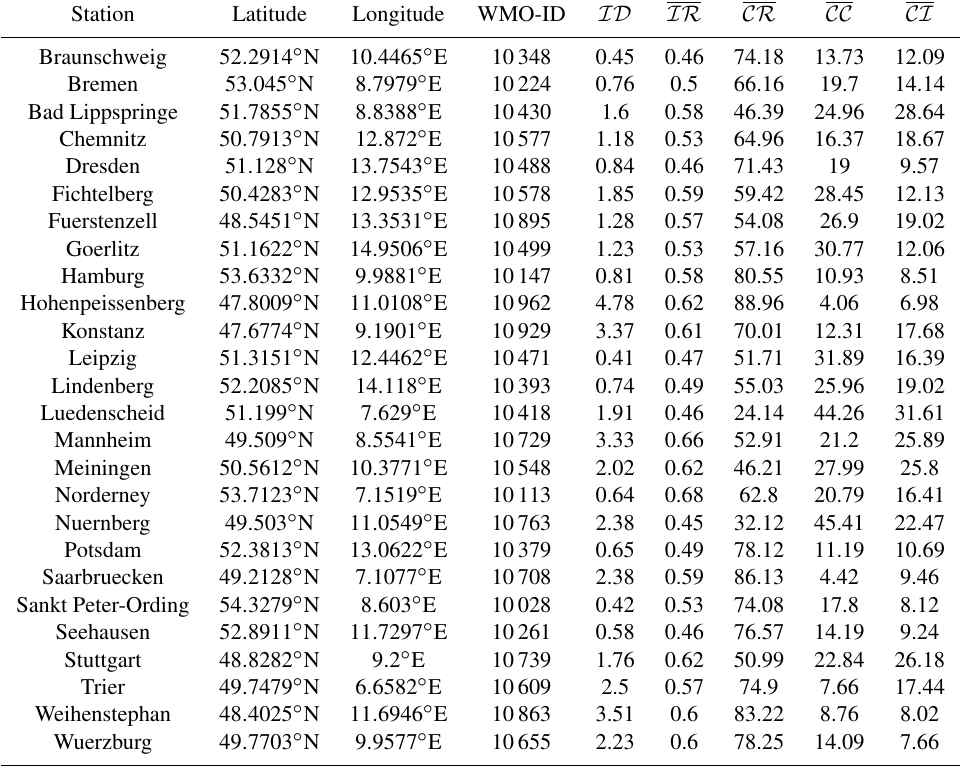
Table C1. Geographical position and characteristic measures as described in Appendix C for SYNOP stations with high-quality radiation measurements in